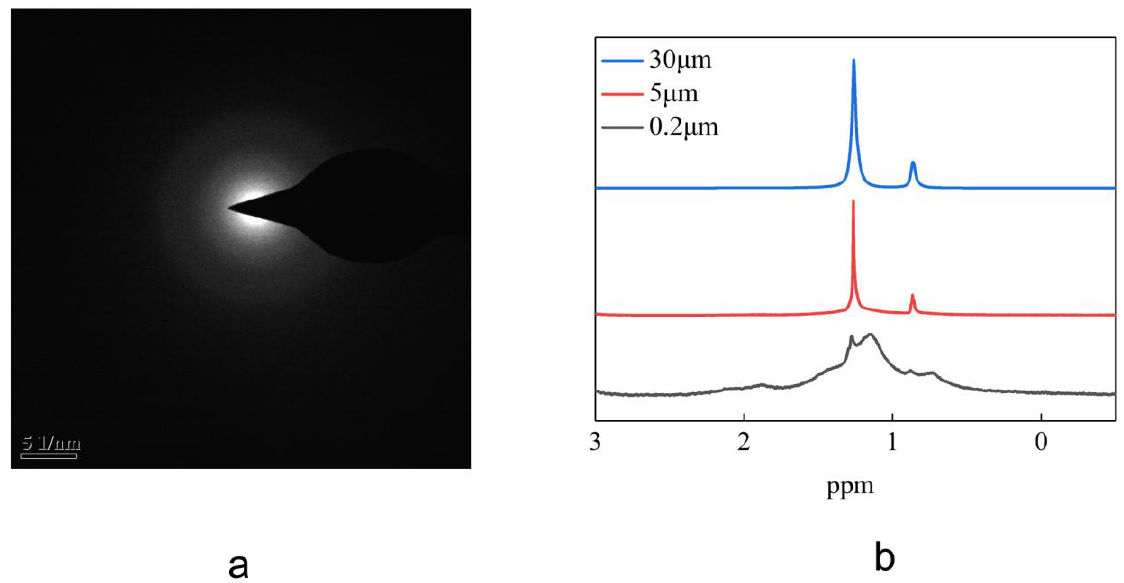
Figure 6. Electron diffraction patterns and NMR H-spectrum of the hexadecane in the silica microtubules. ( a ) shows the electron diffraction patterns of the hexadecane in silica microtubules 2 μm in ID. ( b ) depicts the H-NMR spectrum of the hexadecane in silica microtubules 30 μm, 5 μm and 0.2 μm in ID.